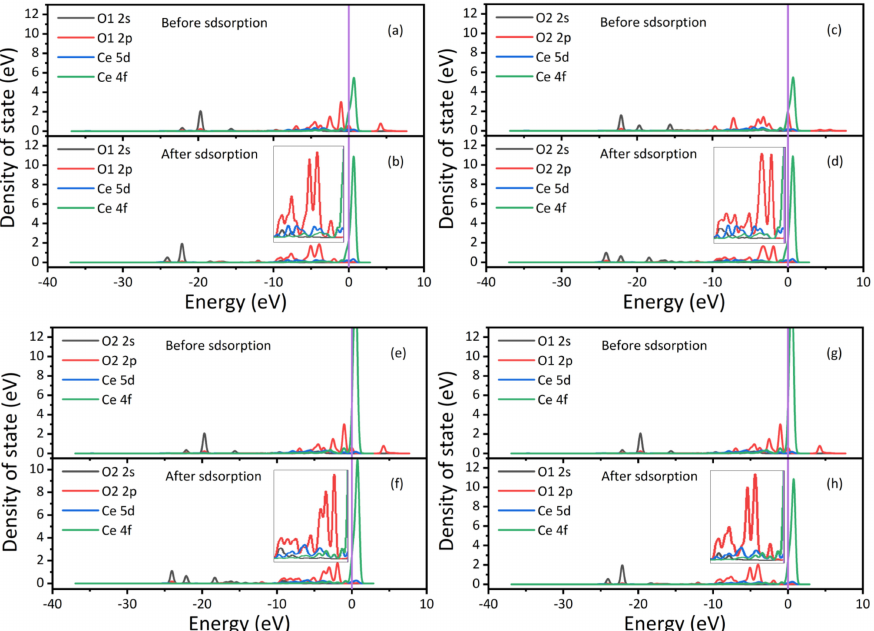
Figure 8. Density-of-state plots after the adsorption of NHA on the La-doped bastnaesite (100) surface: ( a – d ) substitution at position 1; ( e – h ) substitution at position 2.